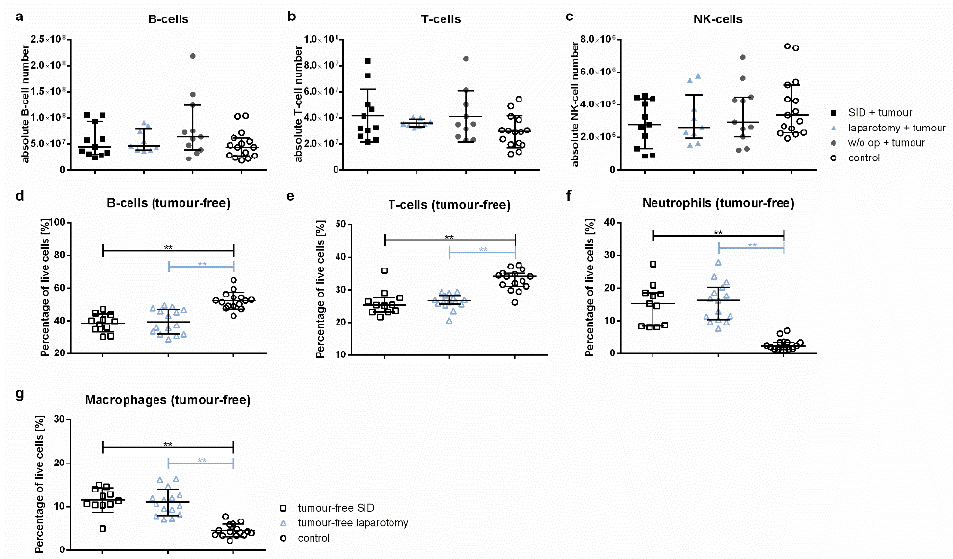
Figure A1. Spleen cell populations. The spleen cell populations were determined by flow cytometry. The graphics either show the absolute cell numbers or the percentage of vital spleen cells. ( a ) The absolute cell numbers of the B-, T- and NK-cells. ( b ) The relative spleen cell numbers in tumour-free animals. Values in ( a , c , e , f ) represent the median with interquartile ranges; values in ( b , d , g ) the mean and standard error with n = 9–15 animals per group (SID + tumour: n = 11; laparotomy + tumour: 9; w/o op + tumour: 11; SID: 11; laparotomy: 15; control: 15); ** p < 0.01.